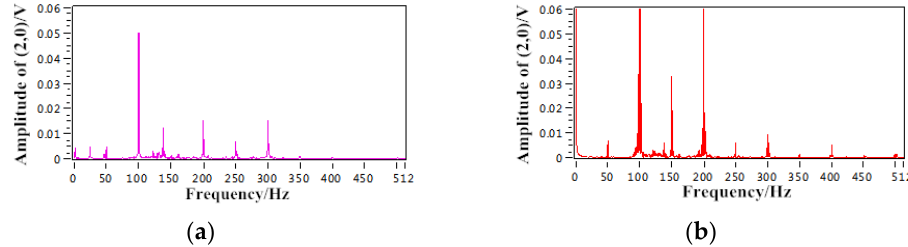
Figure 12. Spectrum diagrams of the vibration signal: ( a ) spectrum diagram of the normal motor; and ( b ) spectrum diagram of the fault motor.